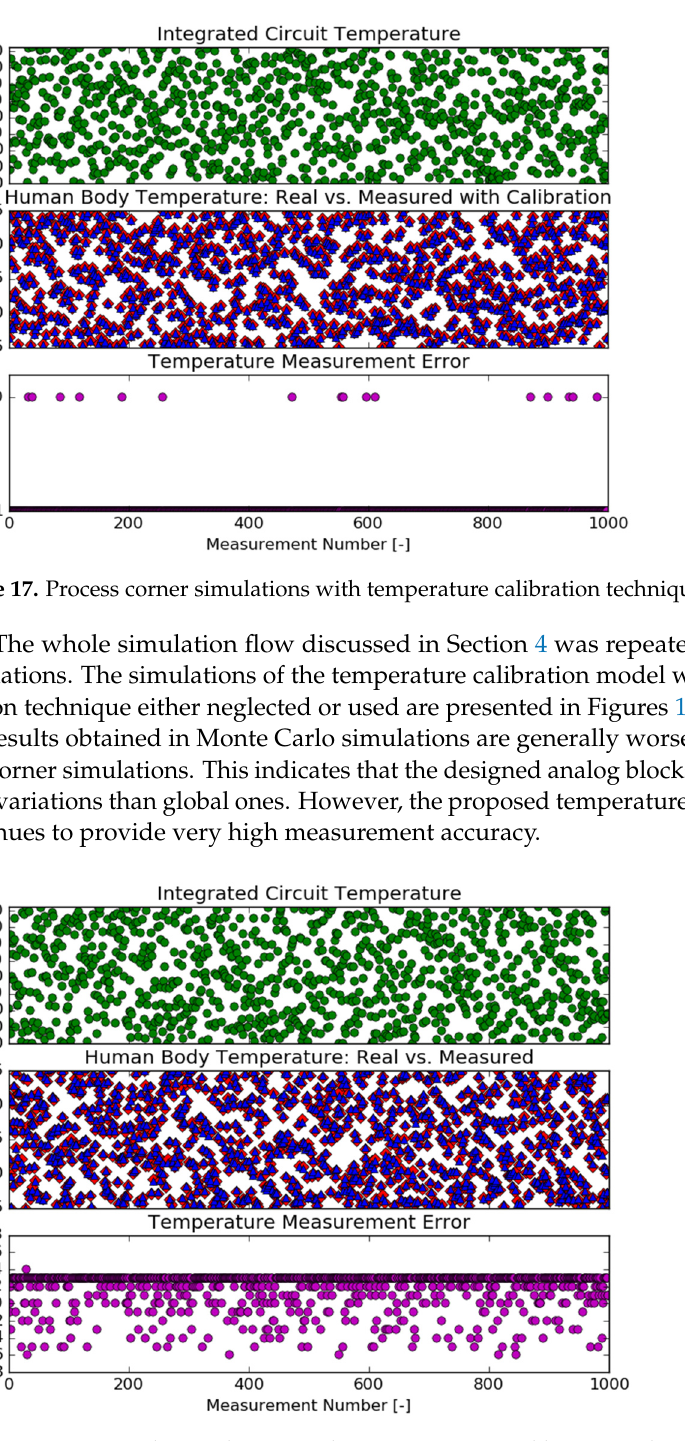
Figure 18. Monte Carlo simulations without temperature calibration technique.